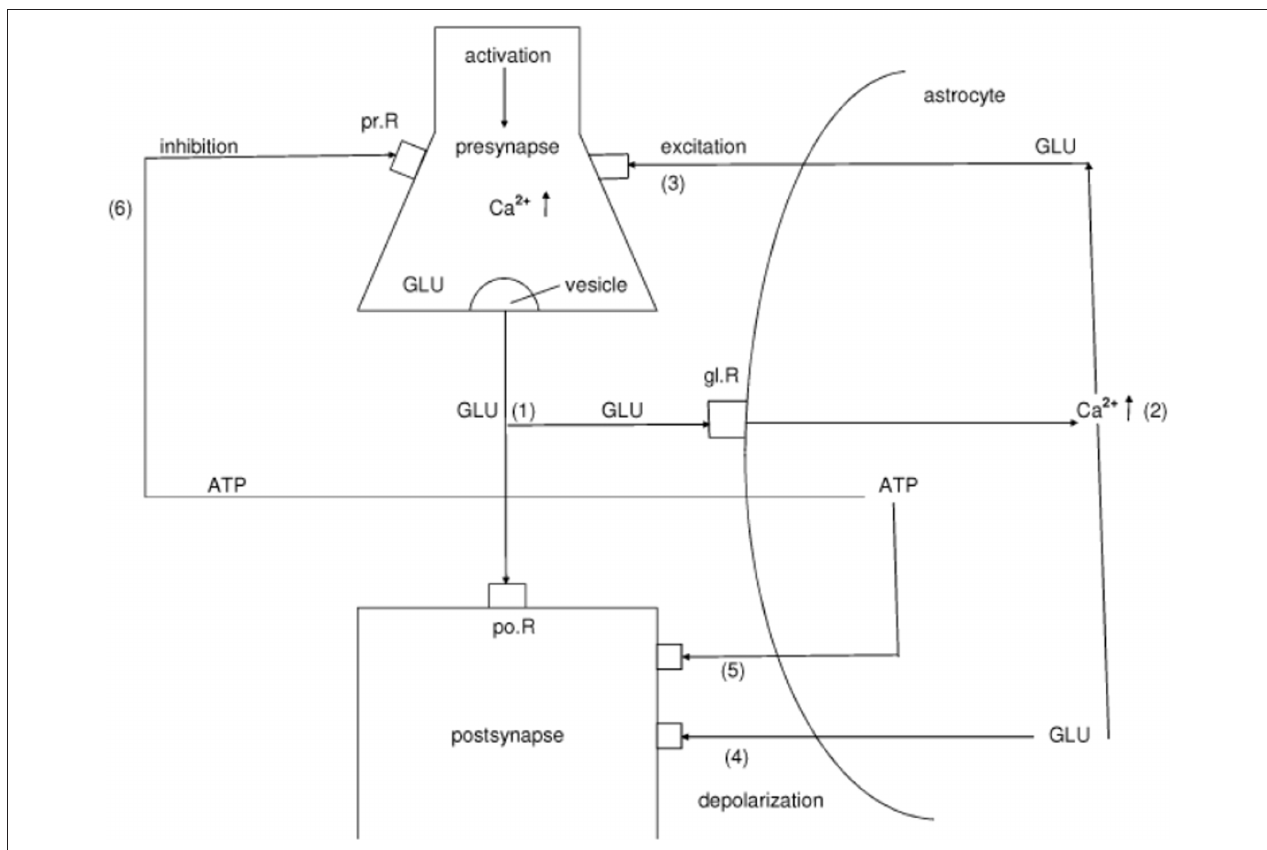
Figure 2 | Schematic diagram of possible glial–neuronal interactions of the glutamatergic tripartite synapse (modified after Newman, 2005). Release of glutamate (GLU) from the presynapse activates (arrows) glial receptors (glR) and postsynaptic receptors (poR) (1), (for the sake of clarity only one receptor is shown). The occupancy of glR evokes a Ca 2 + increase (2) and the